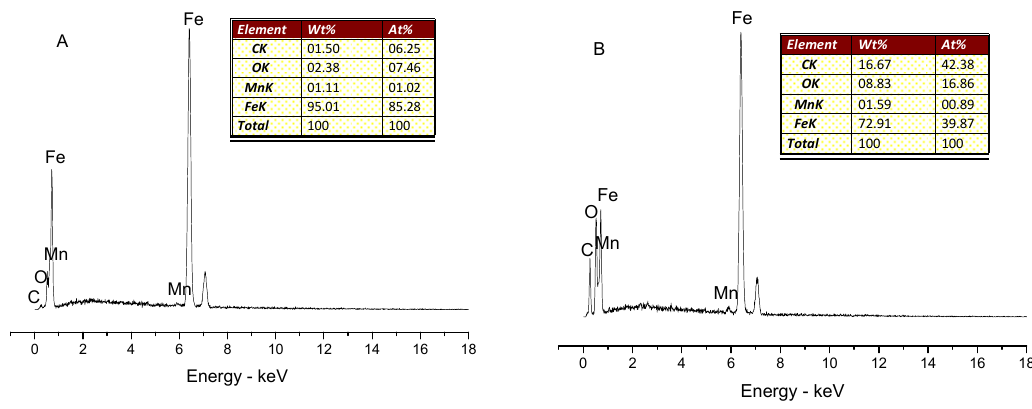
Figure 6. EDS of Fe–Mn ( A ) and Mn-doped Fe/rGO ( B ).